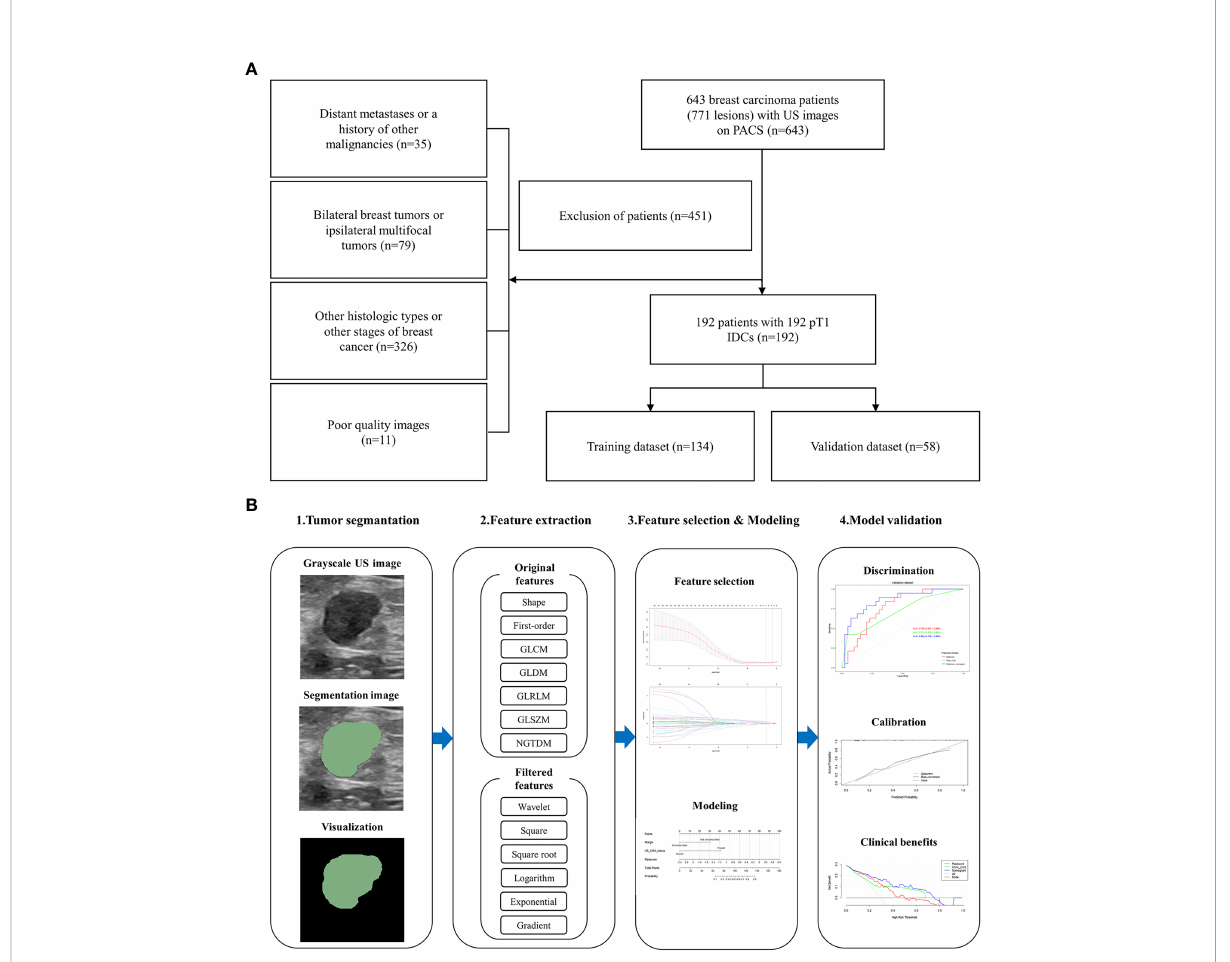
FIGURE 1 Flowchart of this study. (A) The patient selection process. (B) The work fl ow to construct and validate the radiomics